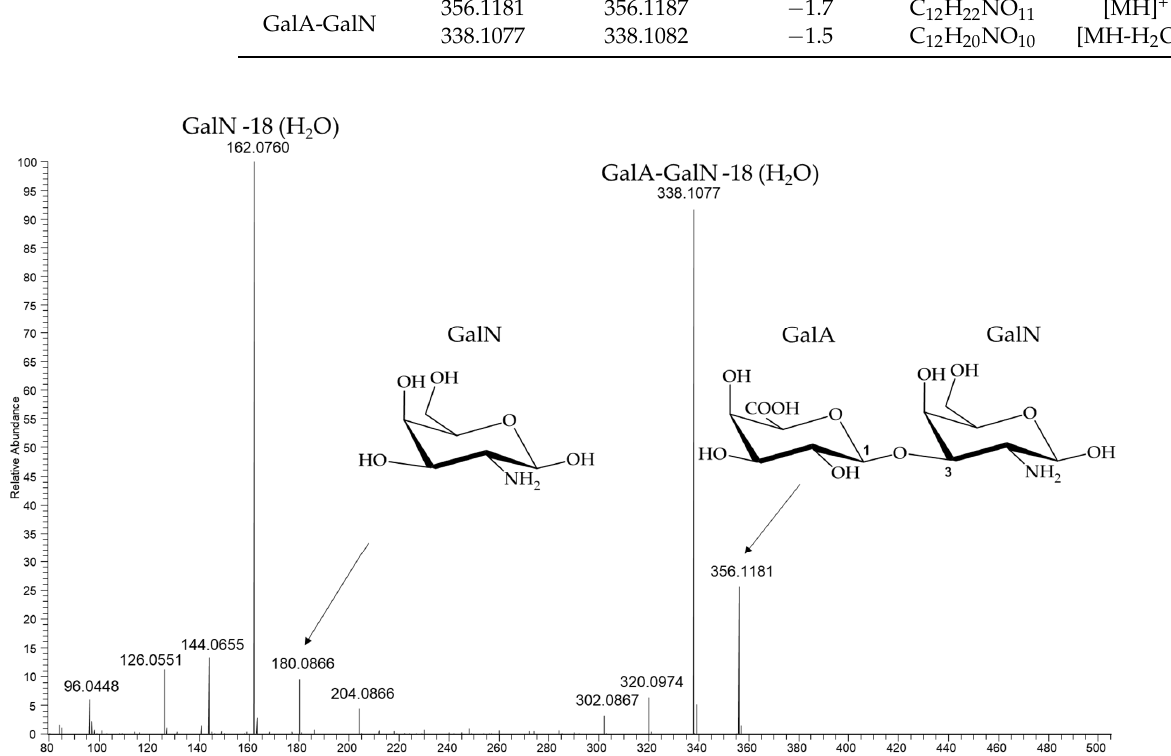
Figure 3. ESI MS spectrum, positive ion mode ([M + H] + ions), of S. flexneri 6 OAg hydrolyzed with TFA 2 M at 100 °C for 2 h, indicating formation of the dimer GalA-GalN.